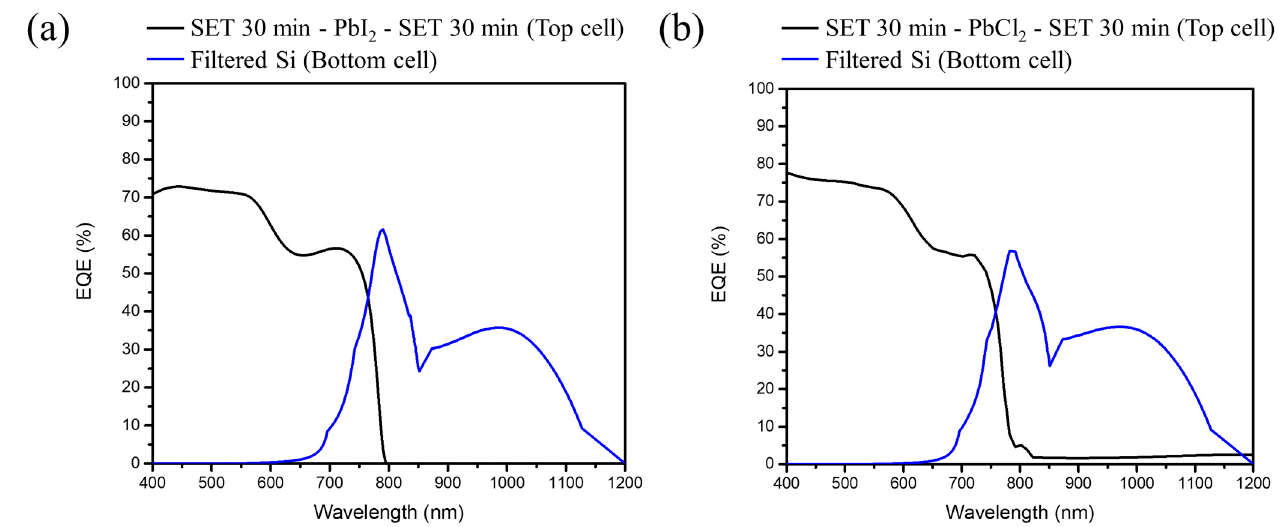
Figure 9. EQE spectra of the perovskite/Si tandem solar cell with the top cell ( a , b ).